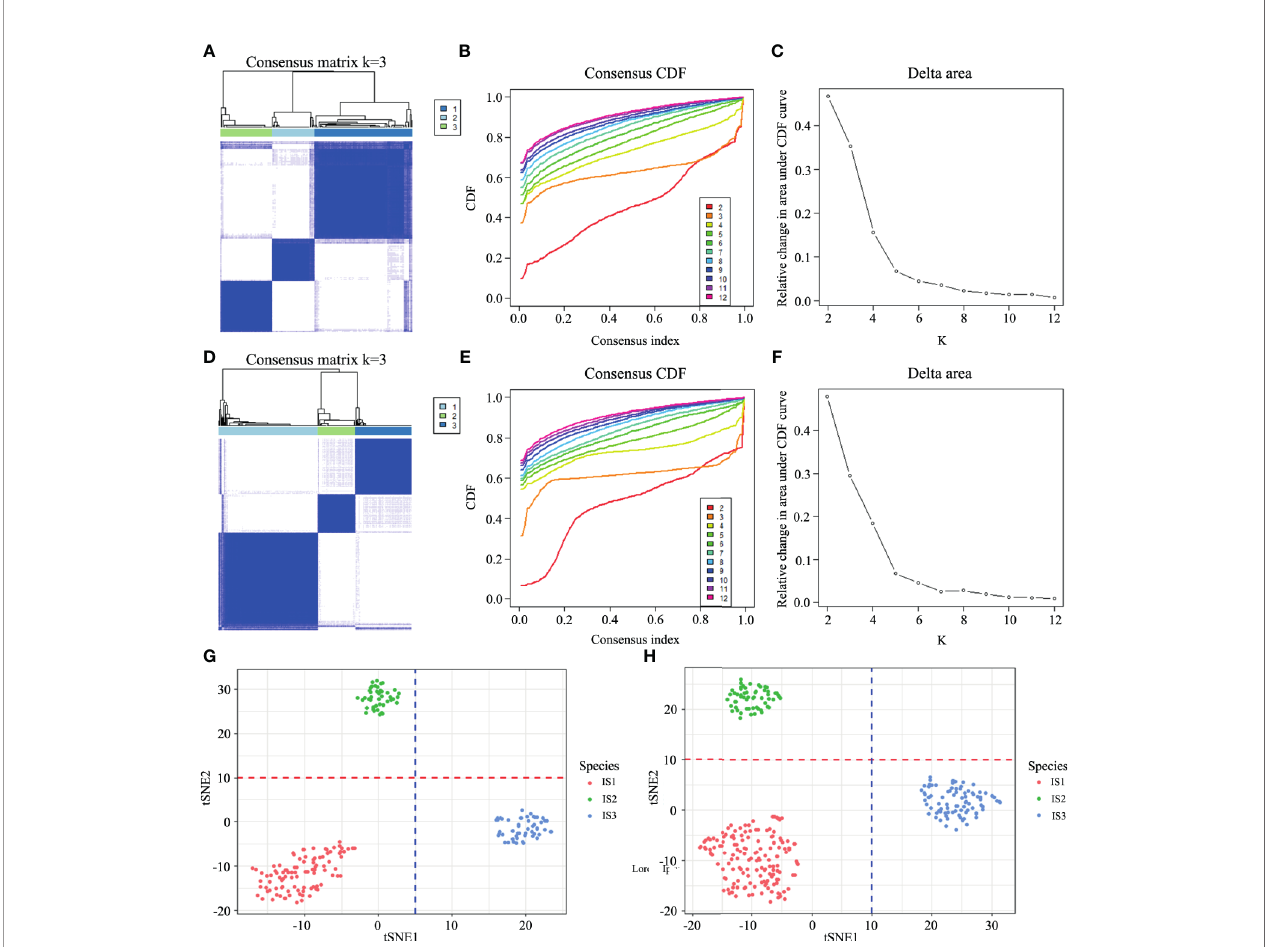
FIGURE 1 | Discovery and validation of the immune subtypes in TCGA (A) and GEO (D) . Patient samples are both in rows and columns, and consensus values range from 0 (never clustered together) to 1 (always clustered together). The optimal cluster number (K = 3) is determined by the area under the cumulative distribution function (CDF) curve in the discovery (B, C) and validation cohort (E, F) , which corresponds to the largest number of clusters that induced the smallest incremental change in the area under the CDF curves. The tSNE well represents the discrete distribution of three clusters (G, H)